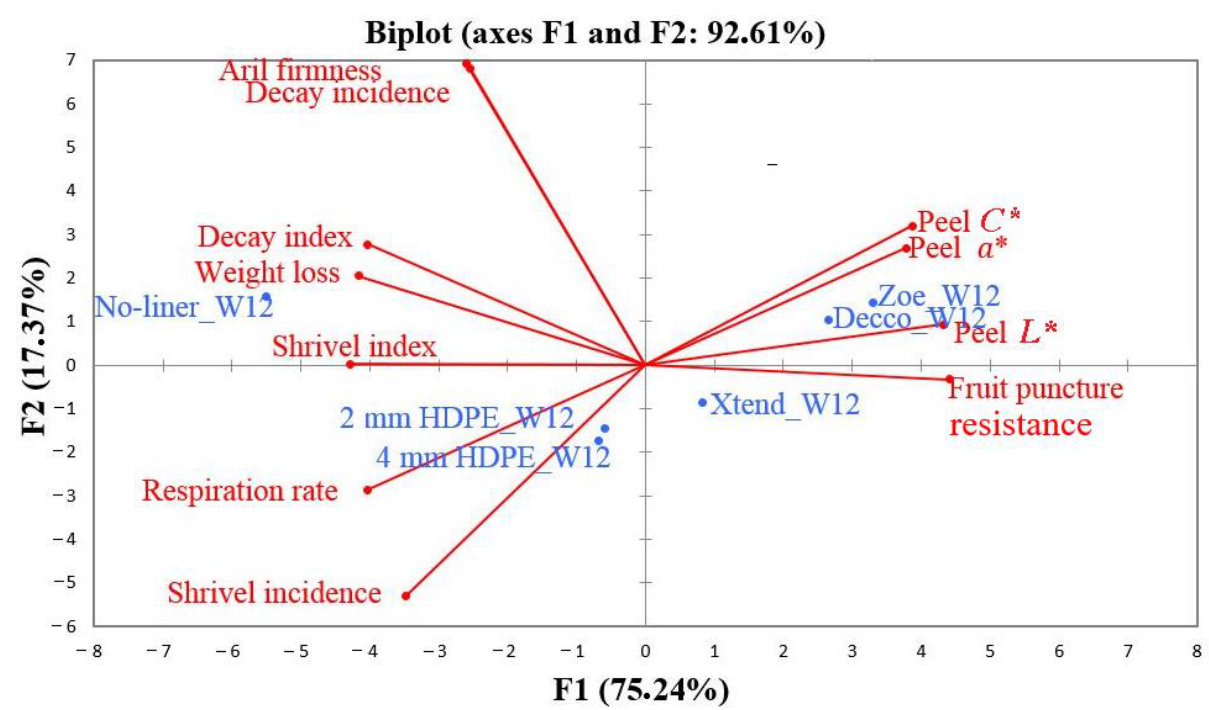
Figure 13. Principal component analysis of the first two factors (F1 and F2) due to physical and physiological attributes of pomegranate (cv. Wonderful) after 42 d of storage at 5 °C and 95% relative humidity (RH). W6 = 42 d. L *: lightness index describes surface color in the range from 0 (black) to 100 (white); a *: redness index describes surface color in the range from green (− a *) to red (+ a *); C *: chroma; HDPE: high density polyethylene.